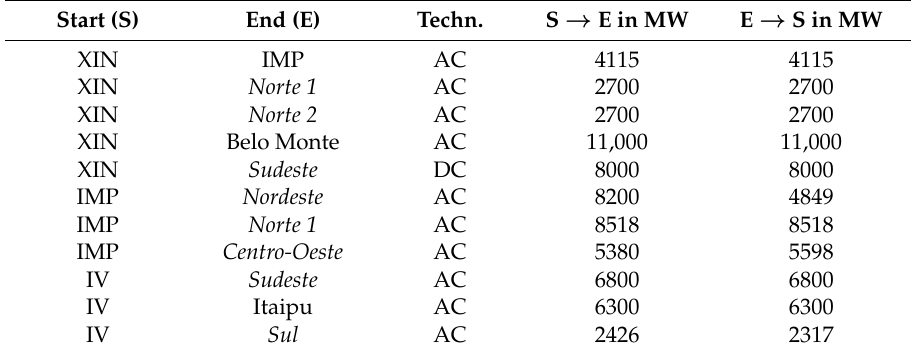
Table A2. Considered existing grid connections and transfer capacities in MW based on